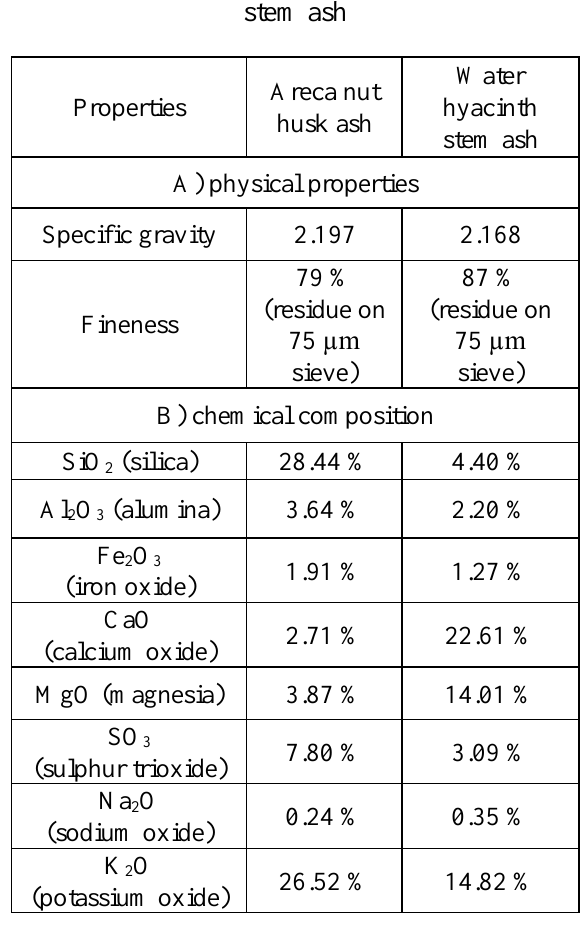
Table 3. Physical and chemical properties of areca nut husk ash and water